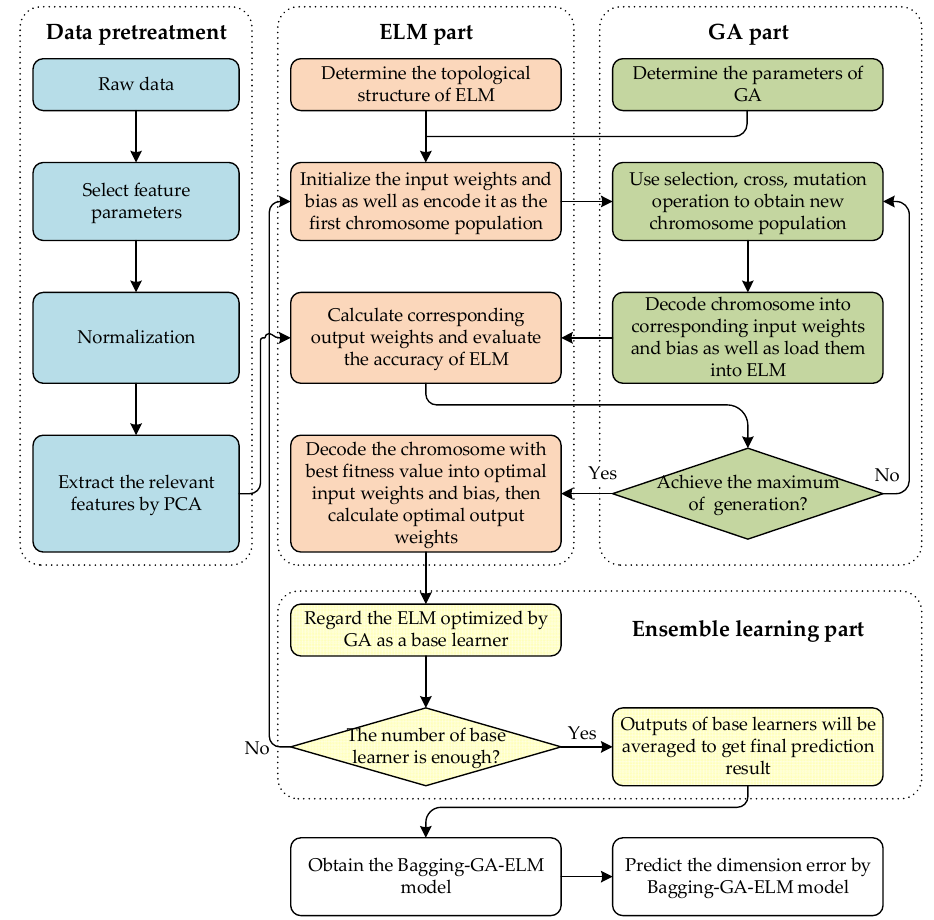
Figure 5. The block diagram of the proposed dimensional error prediction algorithm.